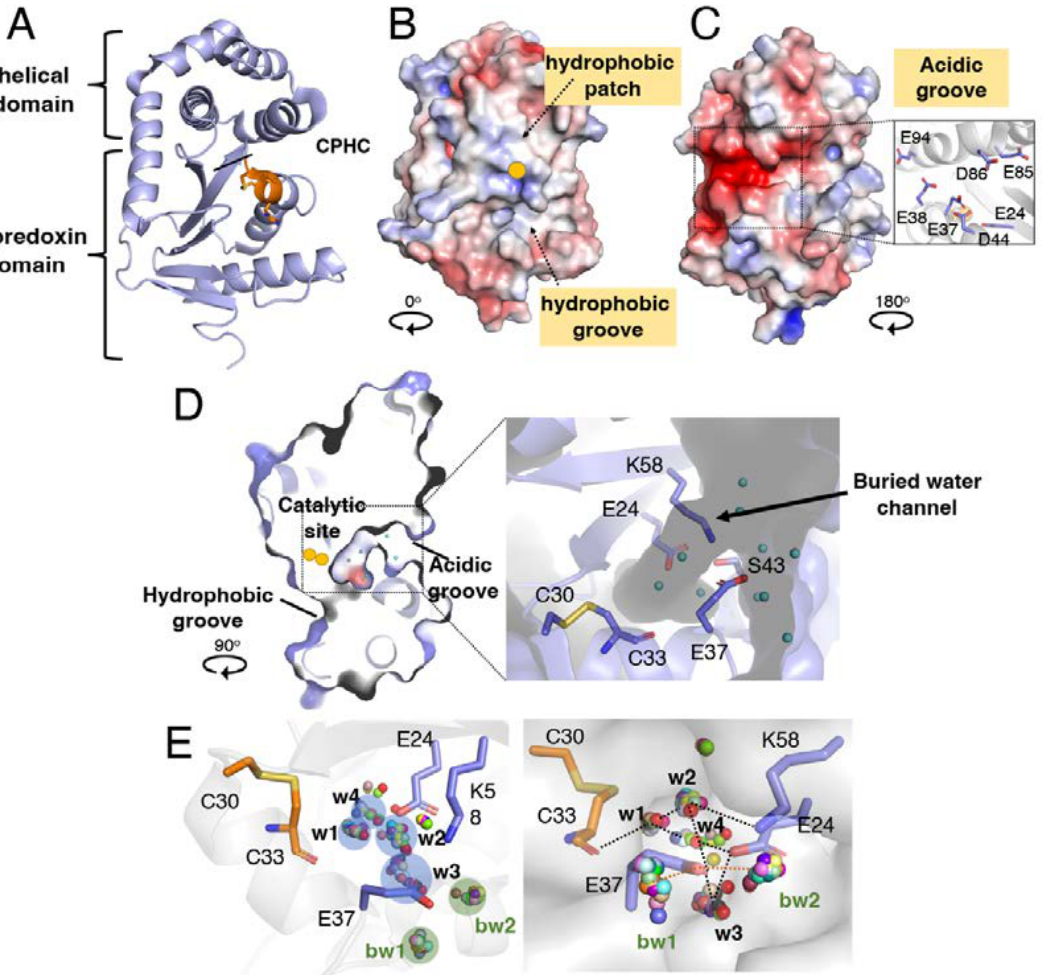
Figure 1. Structure and water network in a buried channel of EcDsbA. ( A ) Crystal structure of oxi- dised E. coli DsbA represented as a ribbon model (PDB: 1FVK). The catalytic site “C 30 PHC 33 ” is col- oured in orange. Electrostatic surface presentation of catalytic face ( B ) and non-catalytic face ( C ) of oxidised EcDsbA. The solvent-exposed active site C30 is shown as a yellow sphere. Inset in B shows the acidic residues present in the acidic groove of EcDsbA. ( D ) Cross-section of EcDsbA structure rotated clockwise by 90° relative to the catalytic face shown in A. The positions of active site residues C30 and C33 are highlighted by yellow spheres. Inset shows a close-up view of a narrow water